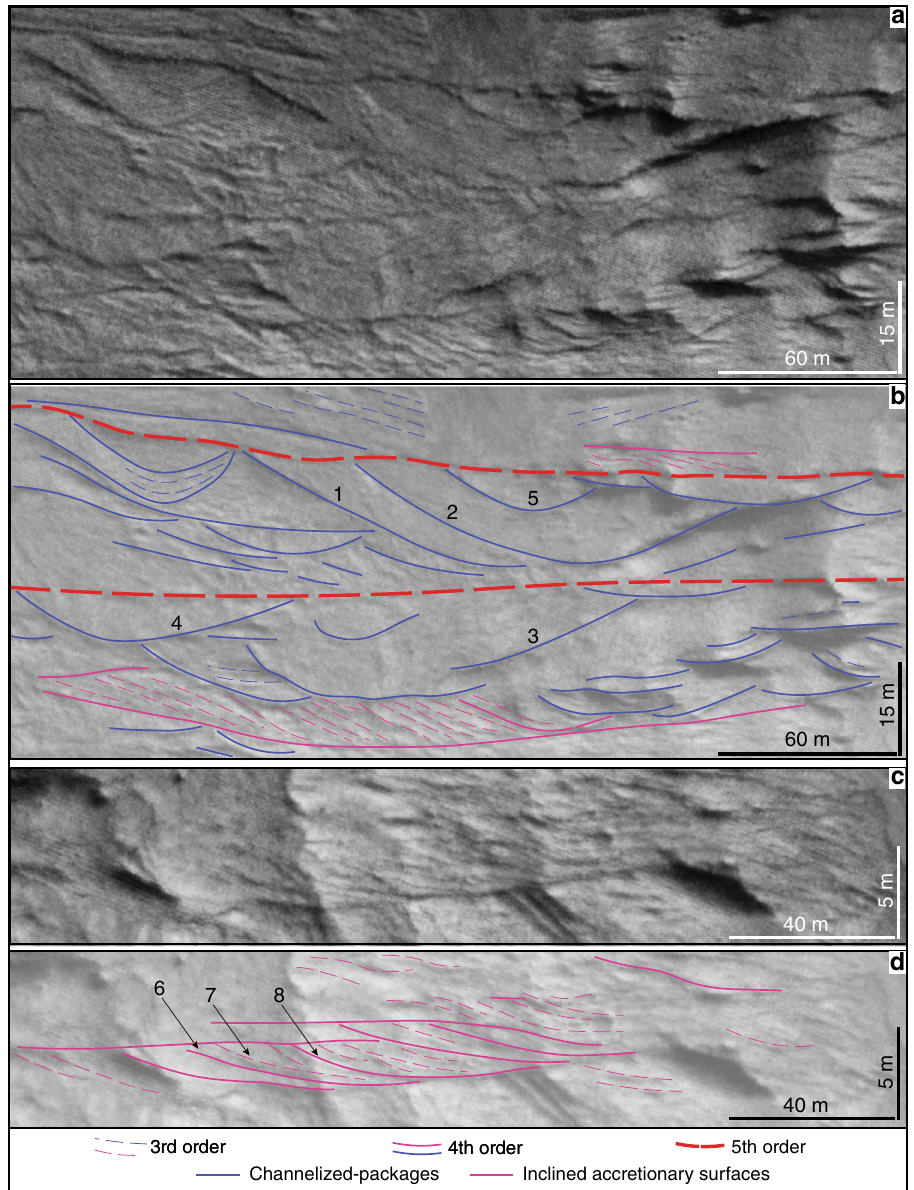
Fig. 3 Example channelised packages and inclined accretionary surfaces. a Close up of white box indicated in Fig. 2b. b Architectural interpretation of a displaying a number of channels (blue lines). Some examples preserve former channel margins, strong evidence for original channel lateral migration. Channelised packages have associated inclined accretion surfaces (magenta lines), with all packages topped and fl oored by more extensive fi fth-order surfaces (red lines). Fifth-order surfaces possibly archive avulsion events. A previous channel margin (1 + 3) laterally coalesces with the fi nal channel margin (2 + 4) indicating that the original active channel migrated laterally. A nested channel-cut (5) is present within a larger channelised package. c Close up of white box indicated in Fig. 2b. d Examples of inclined accretion surfaces with distinct foreset and bottomset elements (topsets truncated by overlying strata). Downlapping of internal, third-order surfaces suggest multiple accretion phases. Note that line drawings are not attempted in areas where exposure is poor. A third-order surface (7) downlaps the bottomset of an underlying fourth-order surface (6) indicating bar migration. A subsequent fourth-order surface (8) truncates the previous fourth-order surface (6) indicating multiple phases of bar-building